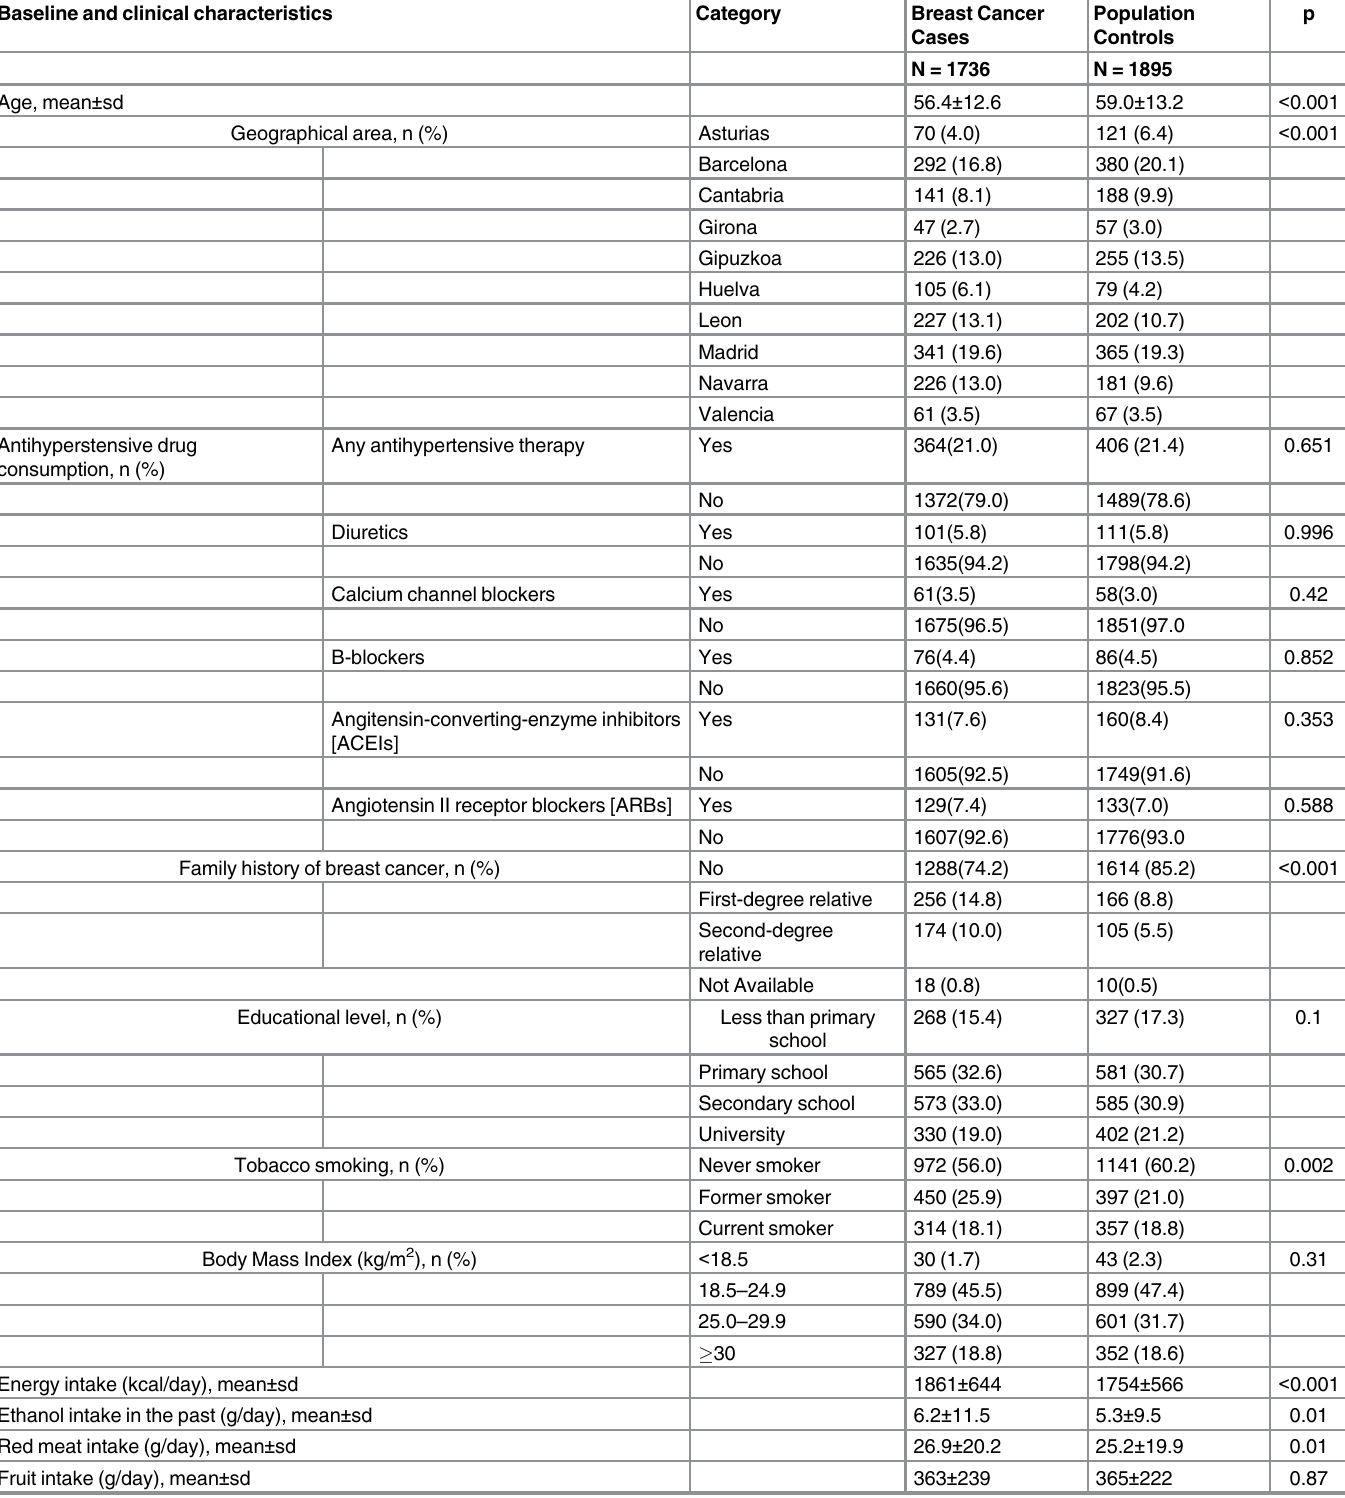
Table 1. Main characteristics of cases and controls from the study population (only women have been